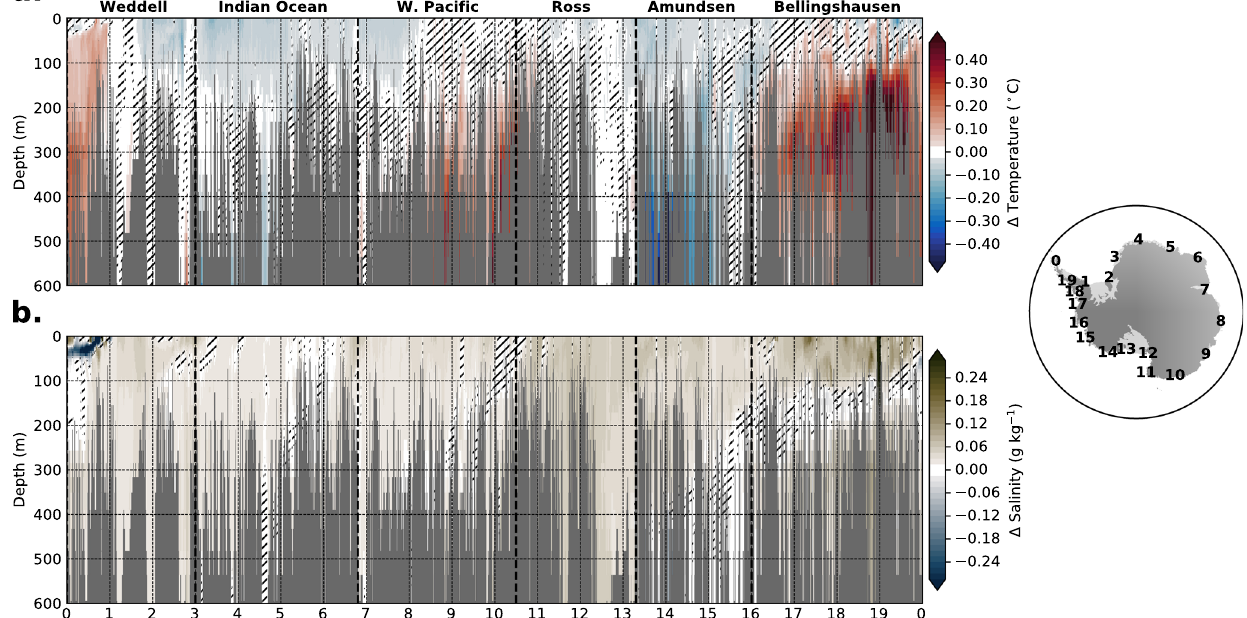
Fig. 3 Ocean conservative temperature and absolute salinity changes at the ice-shelf front due to a positive SAM perturbation. Vertical sections of ( a ) ocean temperature ( ∘ C) and ( b ) salinity (g kg − 1 ) changes between the SAM + run and the CTRL run along the ice-shelf front. Values are averaged over years 25 – 29. Hatching indicates non-signi fi cant changes at the 95% level. The bedrock bathymetry is represented in gray. The x-axis represents the position along the ice-shelf front, indicated by numbers from 0 to 19 located on the inset